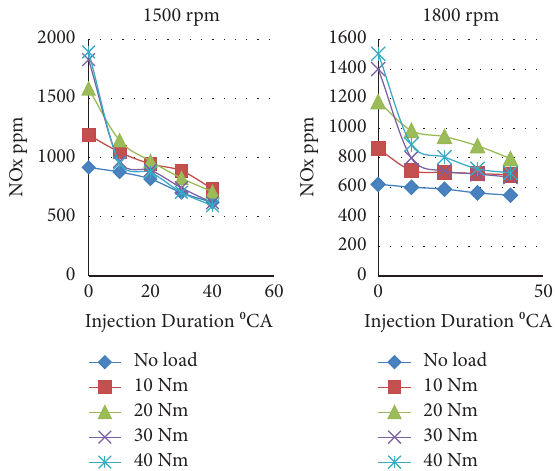
Figure 5: NO x emission for diferent H 2 injection of engine speeds of 1800rpm and 1500rpm.